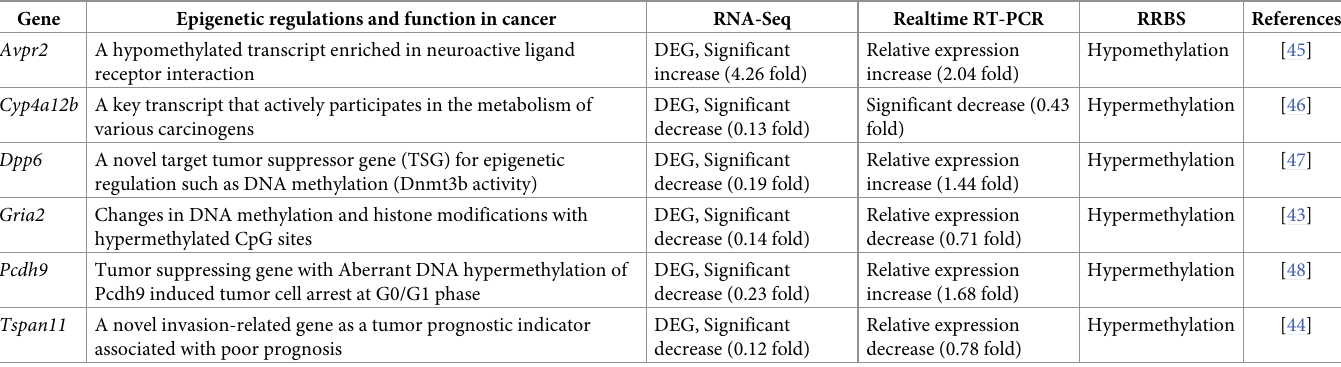
Table 4. Summary of identified key genes in response to maternal BSp